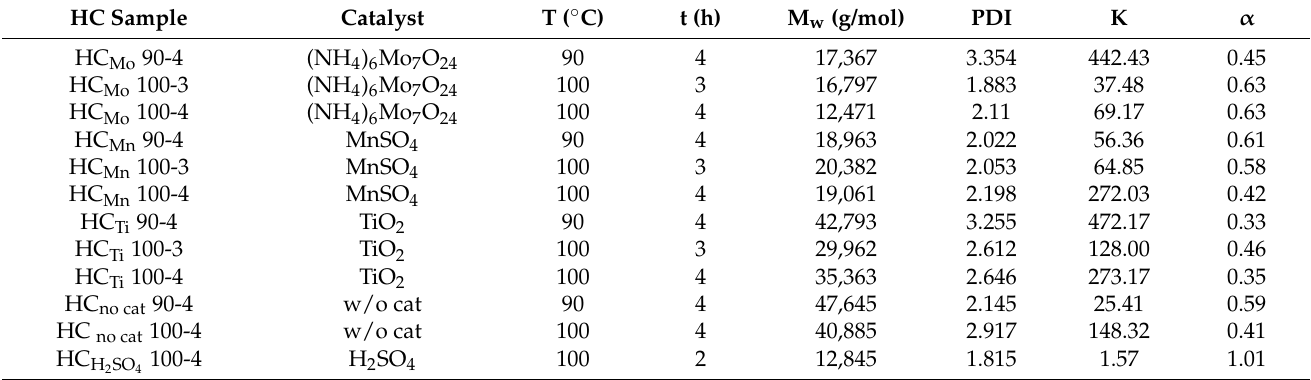
Table 2. Molar mass characteristics of the spruce wood